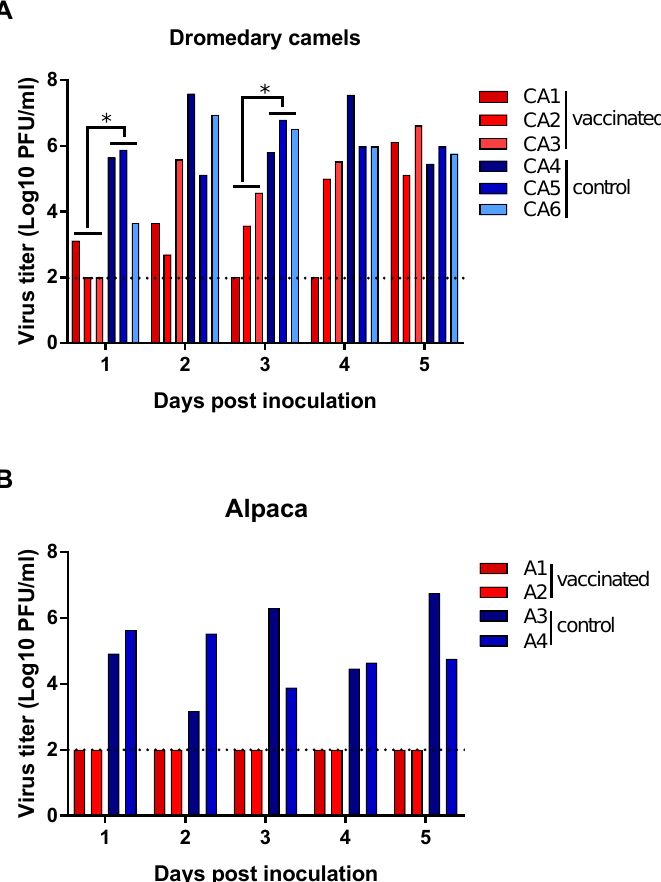
Figure 2. Virus shedding in nasal swabs of vaccinated and unvaccinated dromedary camels and alpaca after challenge with MERS-CoV. Nasal swabs were obtained from dromedary camels ( A ) and alpaca ( B ) daily after MERS-CoV challenge and virus titers in swabs were determined in a plaque assay. Red bars indicate vaccinated animals and blue bars indicate unvaccinated control animals. A dashed line indicates the detection limit of the assay. Asterisks indicate statistically significant difference between geometric mean titers ( P < 0.05).